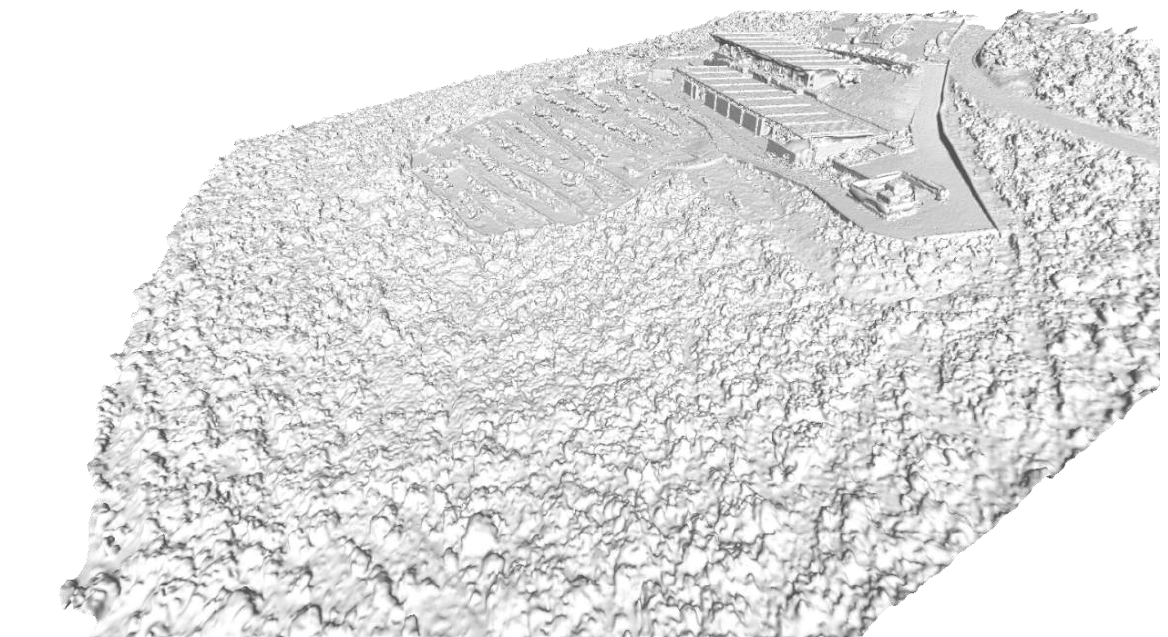
Figure 9. Rural space and building (depth view).